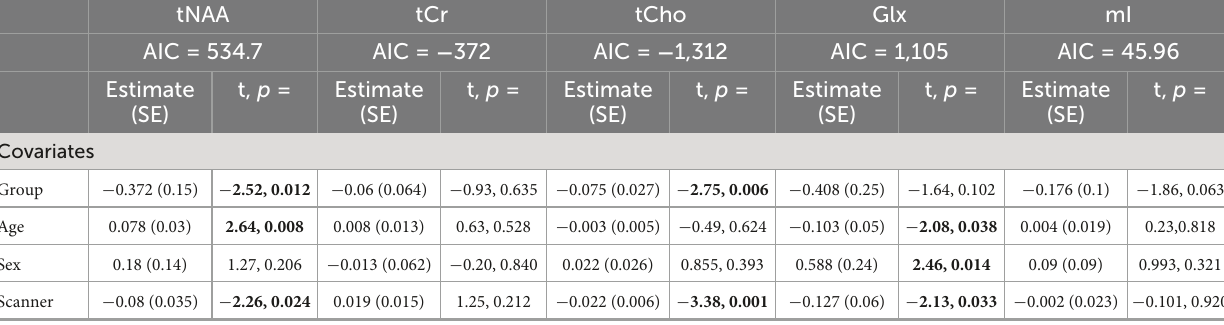
TABLE 4 Summary of the independent univariate general linear model (GLM) models for each metabolite to investigate group differences (concussion vs. OI) in tNAA, tCr, tCho, Glx, and mI (Model 3).